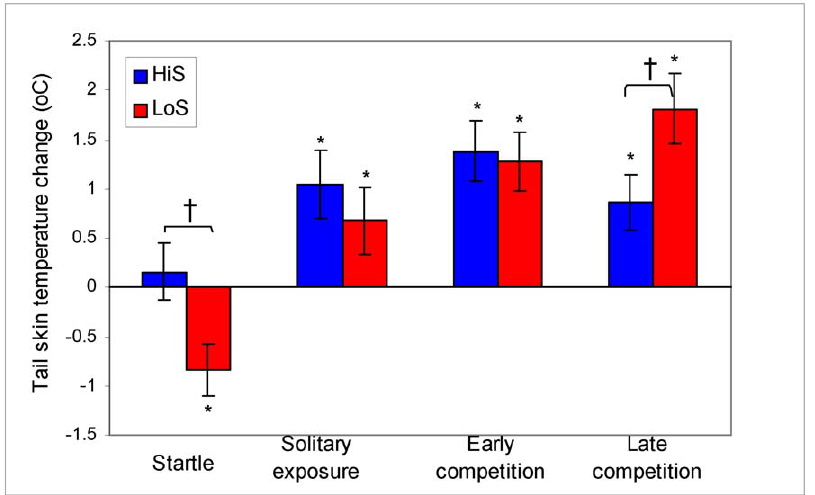
Figure 4. Tail skin temperature (TST) changes (mean 6 C ± s.e.m.) during four challenges. Significant changes (vs 0) are marked with an asterisk (*). Significant line differences are marked with a dagger ( { ).TST dropped during startle testing only in LoS rats. Hyperthermic responses to the competition apparatus (Solitary exposure) and to Competition 3 (Early competition) did not differ between lines but were larger in LoS rats during Competition 9 (Late competition). Note: TST response to startle was measured in 23 dyads; they did not differ from the other dyads in the other tests with respect to line effects.